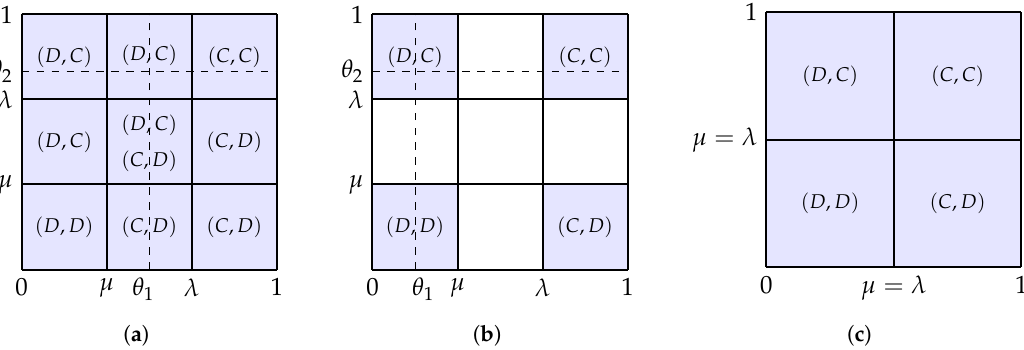
Figure 1. NEs in local games of three double games for PD, the shaded regions represent the continuous types: ( a ) Θ 1 = Θ 2 = [ 0,1 ] , µ < λ , with no pure ex post NE; ( b ) Θ 1 = Θ 2 = [ 0, µ ] ∪ [ λ ,1 ] , µ < λ ,